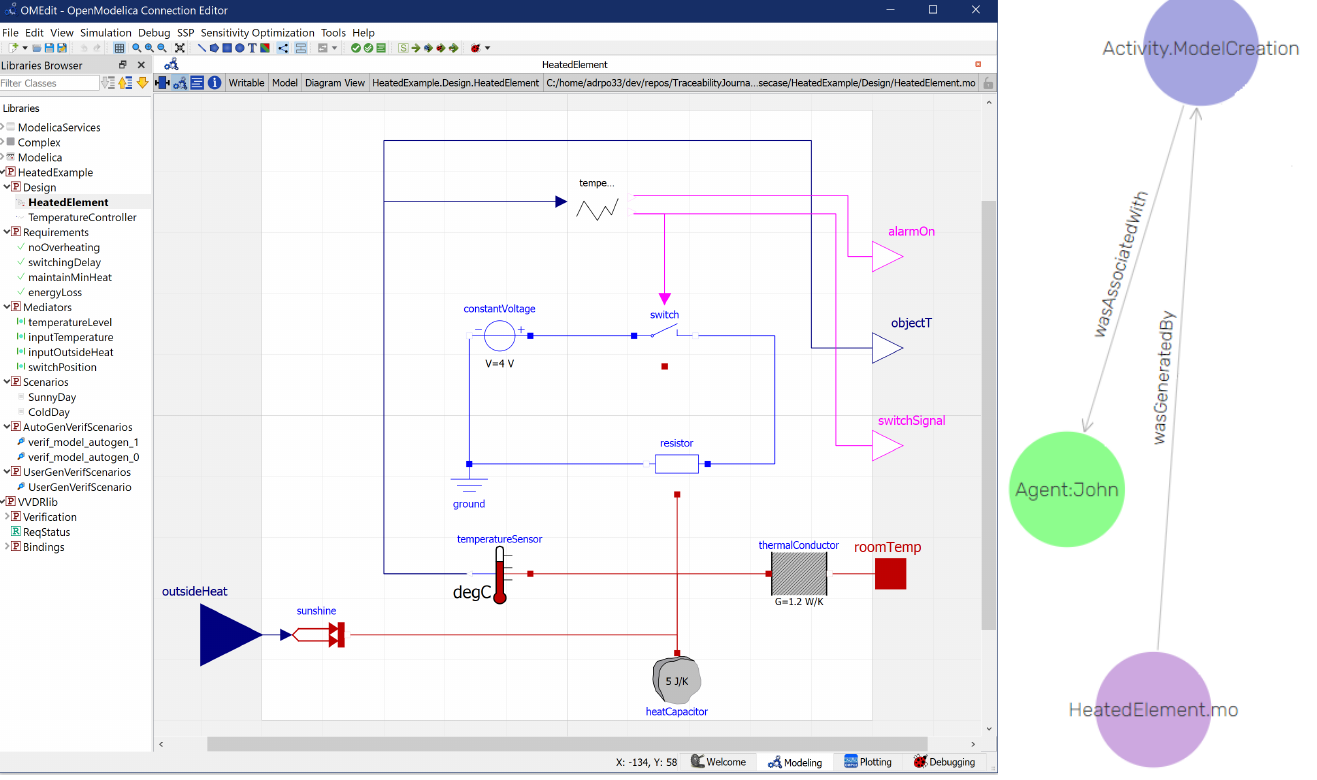
Figure 7. The HeatedElement model in OMEdit and its automatically generated traceablity